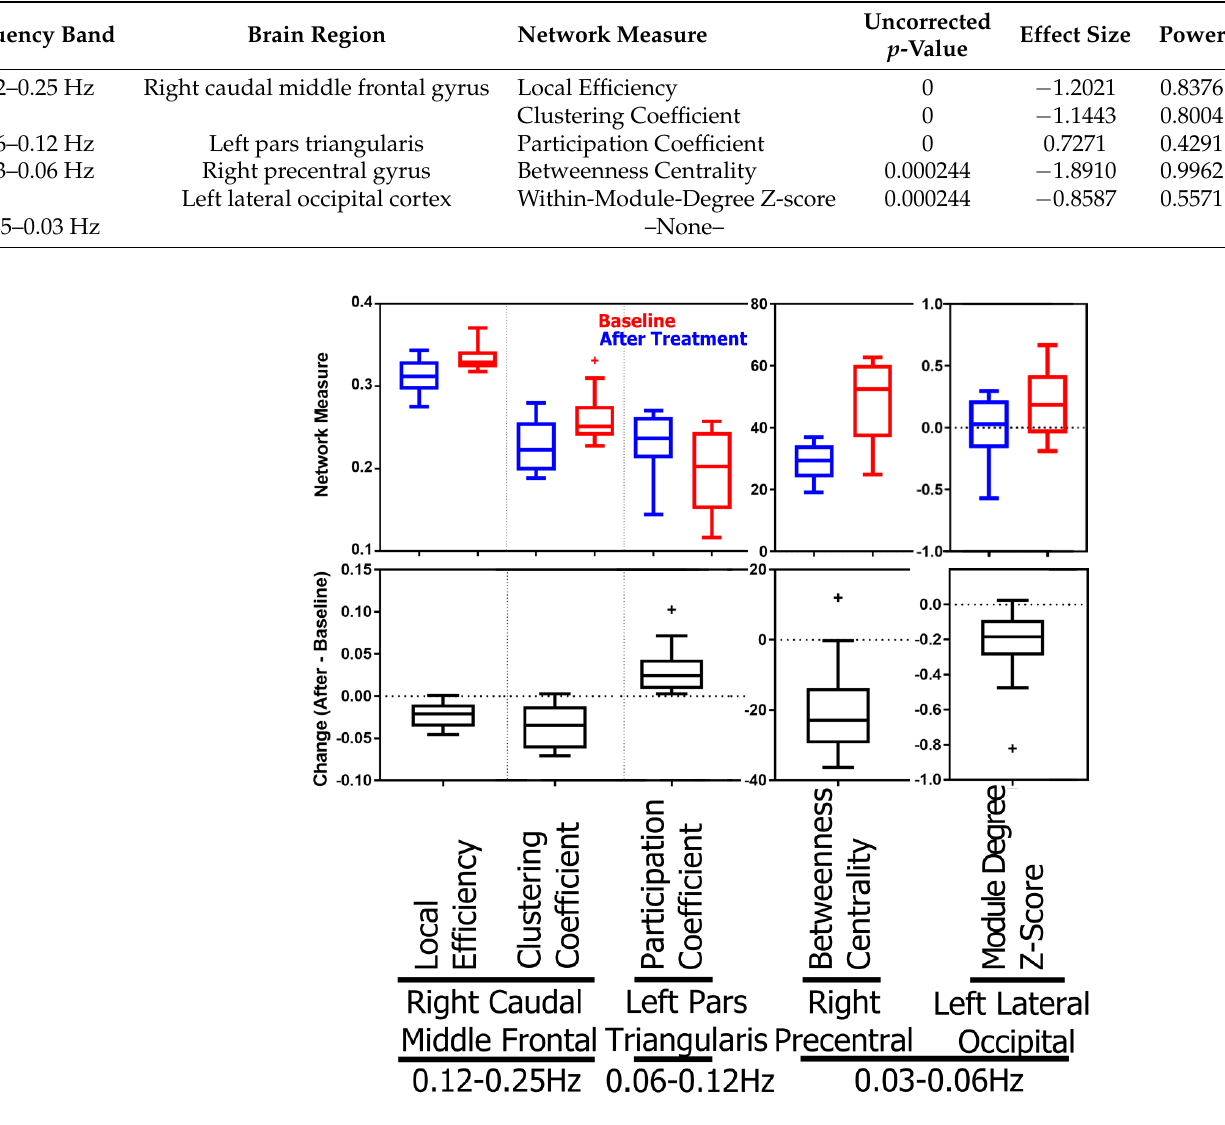
Table 3. Brain regions and altered topological measures ( p -value < 0.05 with Bonferroni correction for 76 regions).